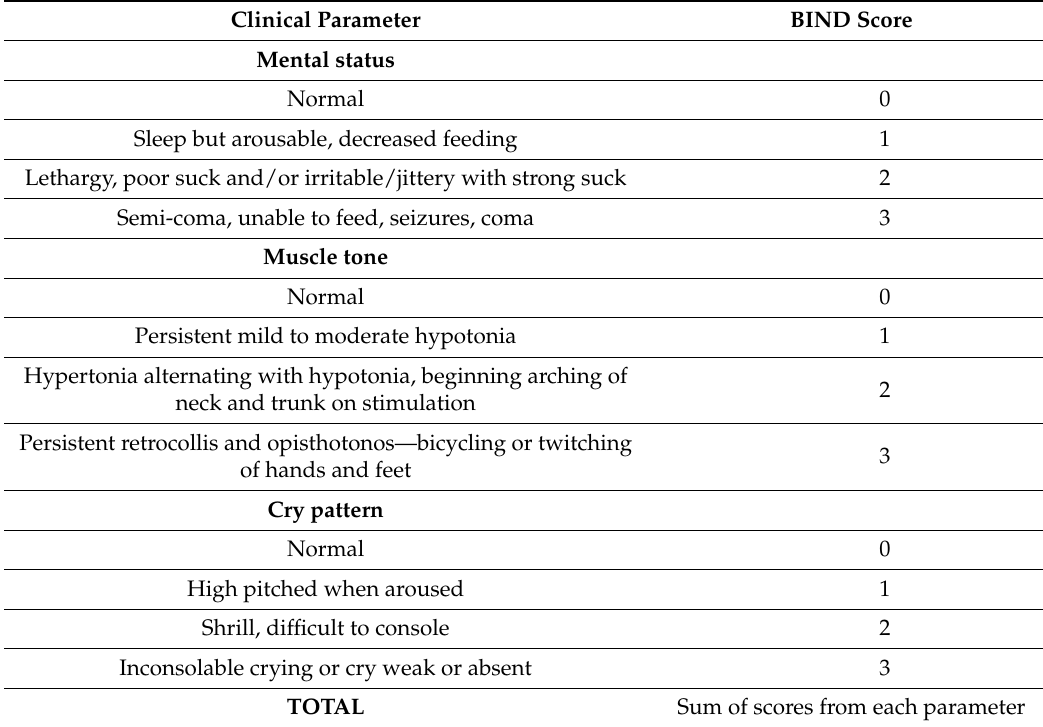
Table 1. BIND Score (Cited from Johnson et al. 2009